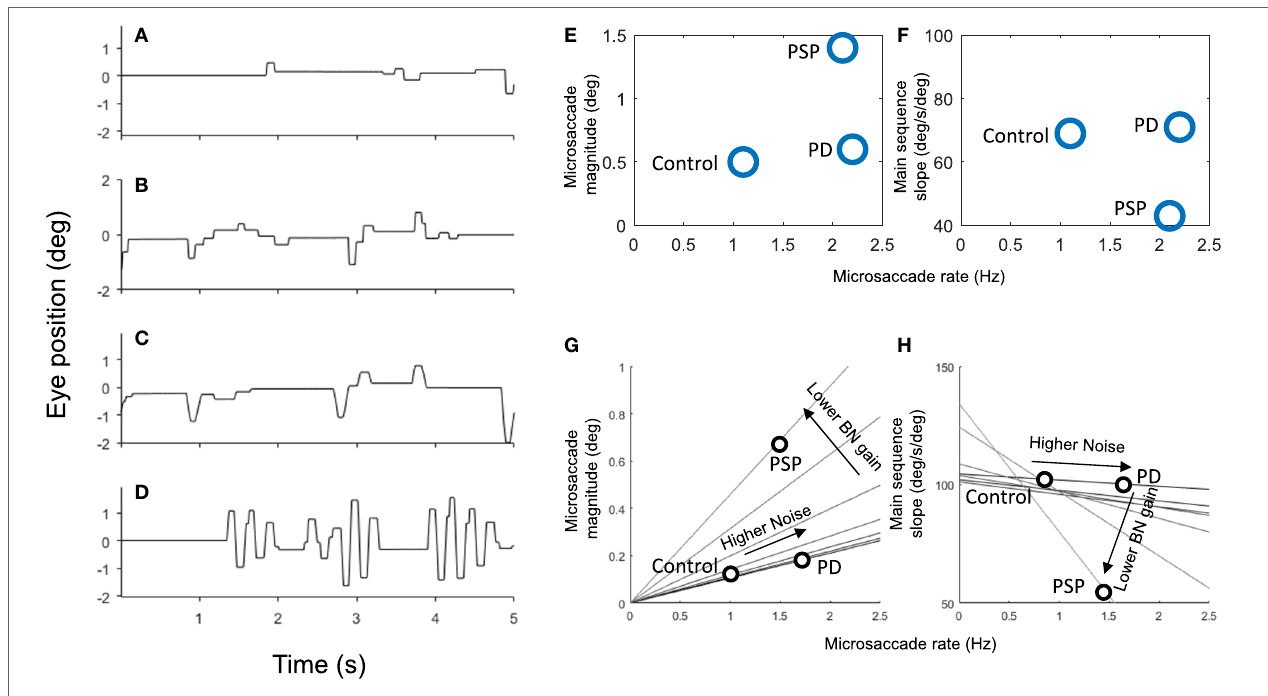
FigUre 9 | Simulation of 5 s of fixation in (a) healthy observers (i.e., using normal parameters), (B) Parkinson’s disease (PD), (c) progressive supranuclear palsy (PSP), and (D) spinocerebellar ataxia. Panels (e,F) show the microsaccade magnitude, rate, and velocity (main sequence slope) of three populations of healthy controls, PSP patients, and PD patients from a previous study (12). Panels (g,h) show the relationship between microsaccade magnitude, rate, and velocity as we vary two parameters of the simulations. Each line represents a set of simulations with the same burst neuron (BN) gain but varying amounts of noise. As noise increases, the rate (and to some extent the amplitude) of microsaccades increases. Peak velocity is not affected by the noise as long as the BN gain is normal. As we lower the BN gain, the velocity of microsaccades decreases while their amplitude increases. The microsaccade rate also decreases, but in the case of the PSP that is compensated by higher